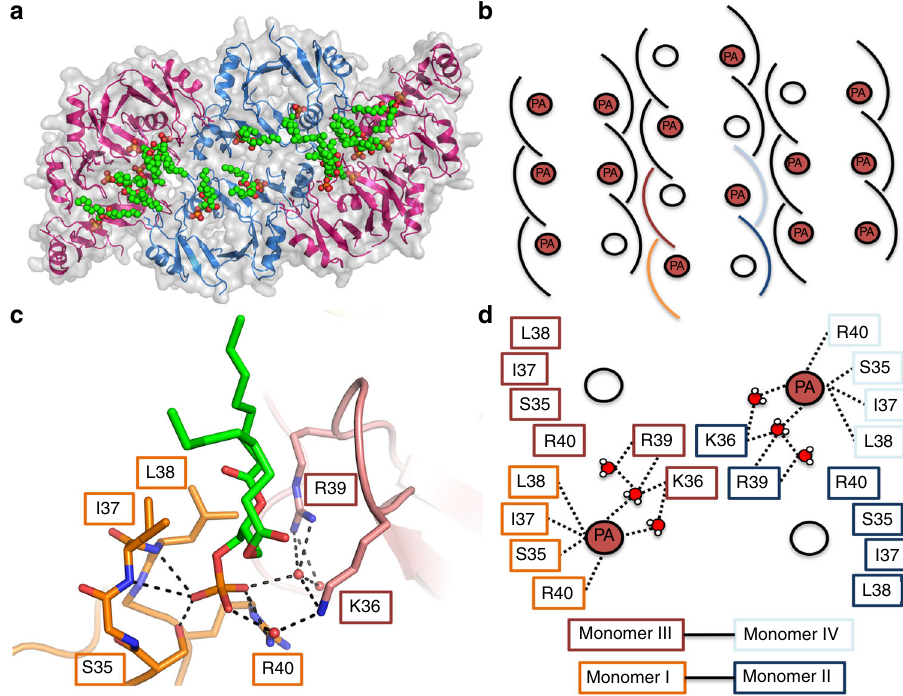
Fig. 4 The NaD1 – PA complex contains 14 PA molecules bound in identical NaD1-dimer binding sites. a The 20-meric complex (cartoon representation with gray transparent surface rendering, with the two 3-dimer arcs in pink, and the central 4-dimer arc in blue) harboring 14 bound PA molecules (shown as spheres with carbon in green, oxygen in red, phosphorus in orange), as viewed from the bottom. b A schematic of the three constituent arcs of the 20- meric complex. Each dimer engages one or two PA molecules (red circles), with the full complex binding 14 PA molecules in total. c A representative NaD1 – PA binding site, with PA (shown as sticks) located within the cationic grip. One monomer of the dimer (orange) engages the PA phosphate head group through Ser35, Ile37, Leu38, and Arg40, while Arg39 and Lys36 (pink) of a single chain from a neighboring dimer are recruited through a hydrogen bond network involving three water molecules that are conserved in each binding site. d A schematic of how two dimers from c cooperatively bind two PA molecules